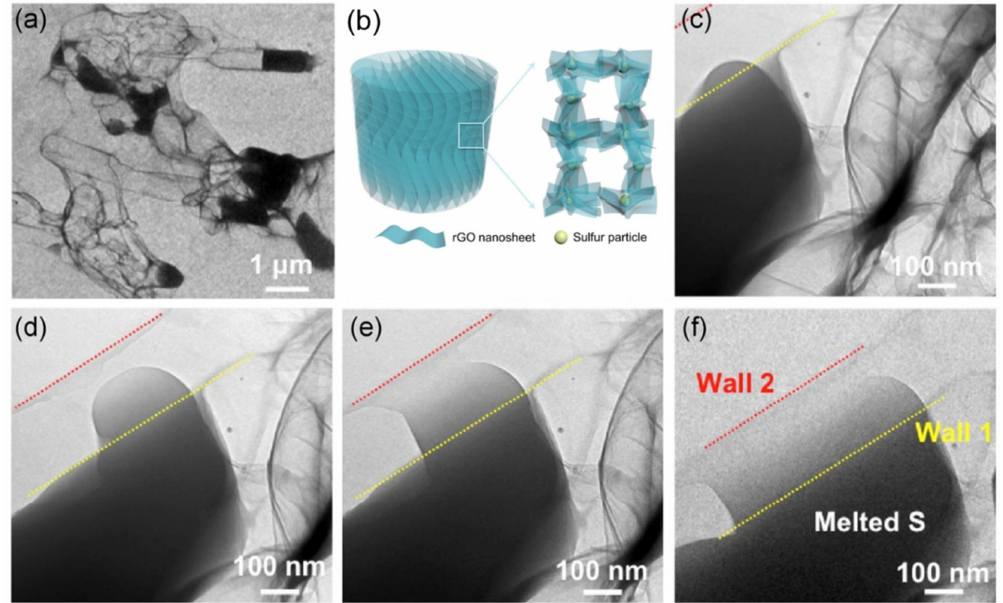
Figure 13. ( a ) TEM image of sulfur particles encapsulated in the 3D graphene structure. ( b ) Schematic drawing of freestanding 3D graphene–sulfur composite. ( c – f ) Multiple frames of melted sulfur migrating and being contained within the 3D graphene structure. Reproduced with permission from ref. [148]. Copyright 2016,